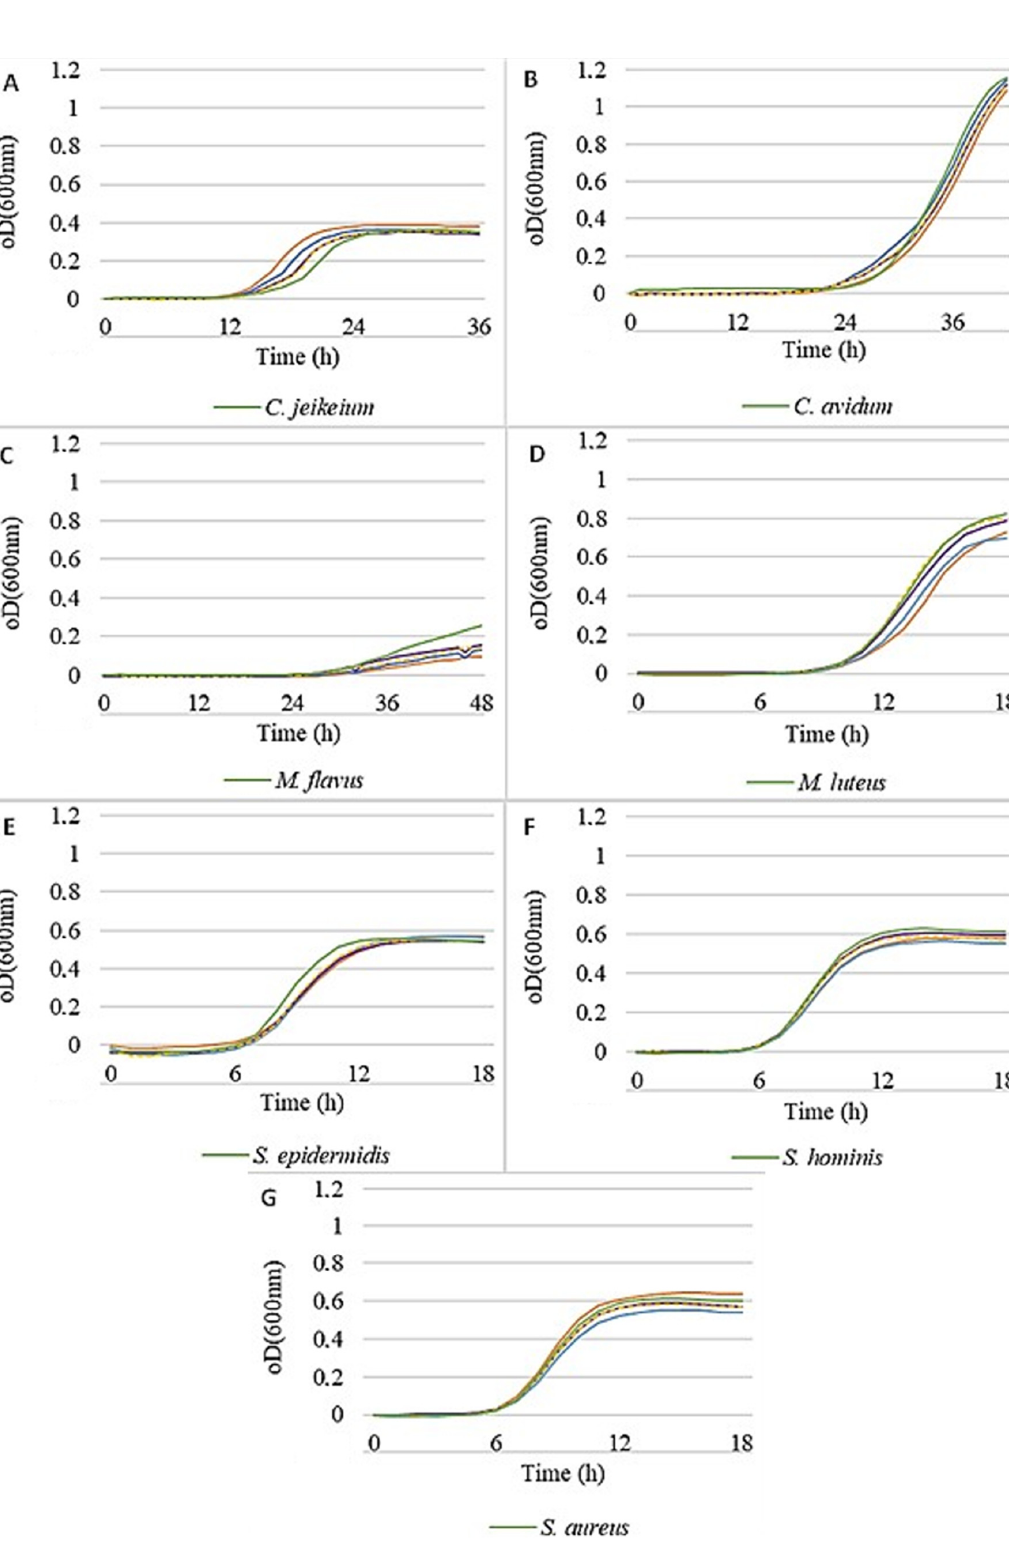
Figure 1. Growth curves for C. jeikeium ( A ), C. avidum ( B ), M. flavus ( C ), M. luteus ( D ), S. epidermidis ( E ), S. hominis ( F ) and S. aureus ( G ) with active 1 in different application concentrations. Red line: 4%, blue line: 2%, black line: 1%, yellow dotted line: 0.5%, green line: control. Curves represent mean values of triplicates for each measurement.